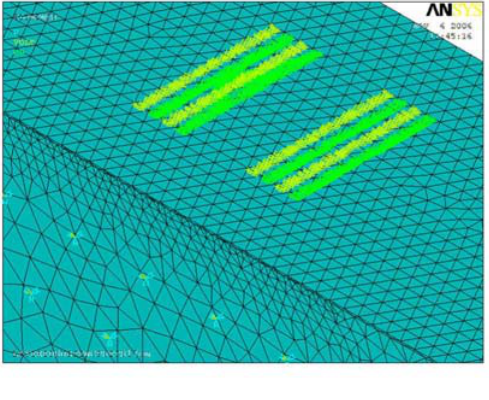
Figure 3. Electrodes modeled as coupled node